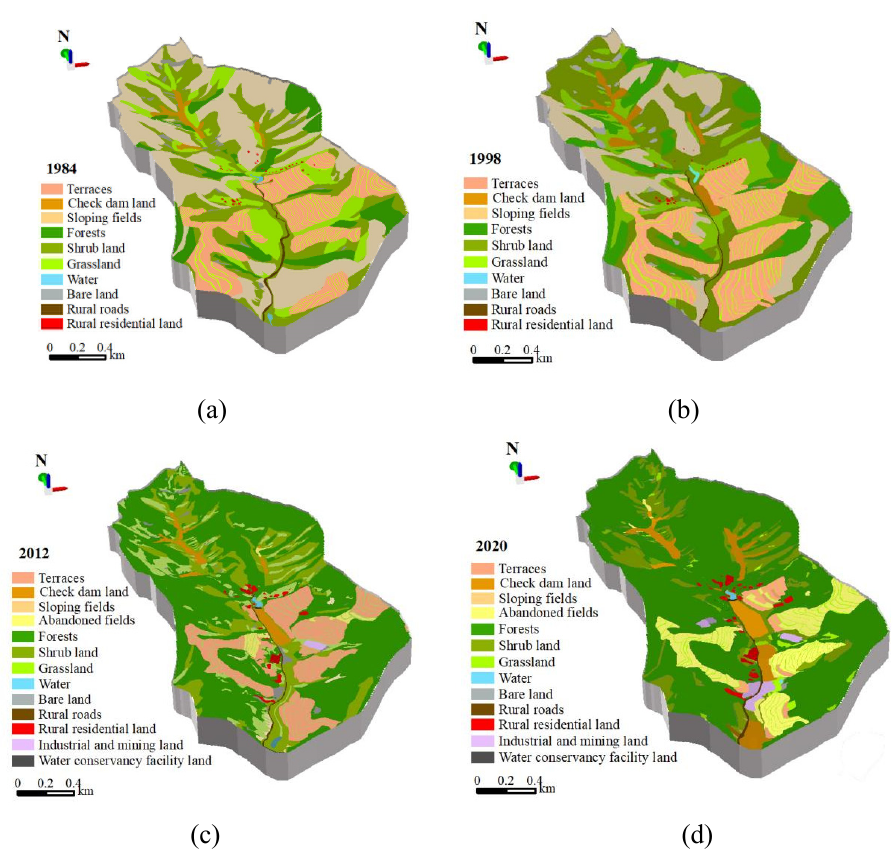
Figure 2. Land use types of the study area in 1984 ( a ), 1998 ( b ), 2012 ( c ) and 2020 ( d ).